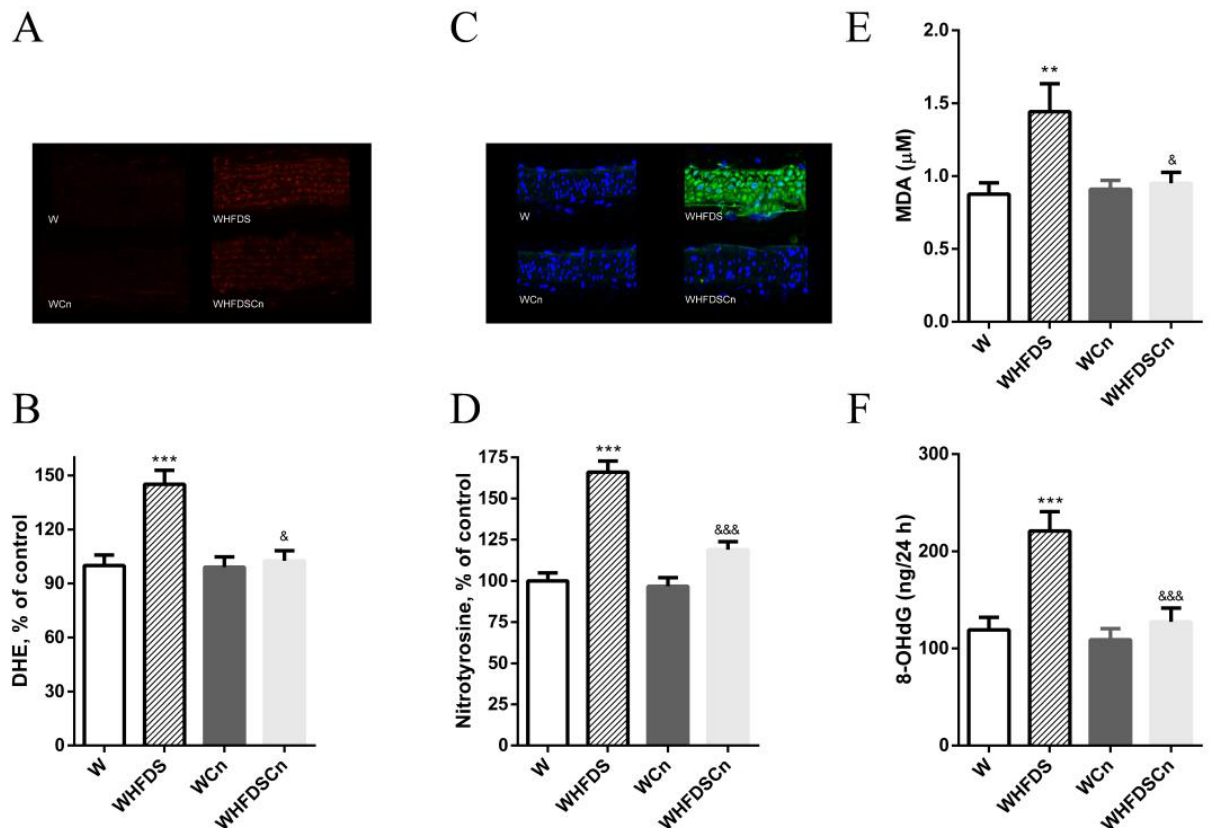
Figure 4. Effects of cinnamaldehyde (Cn) treatment on systemic and vascular oxidative stress in Wistar (W) rats fed with sucrose and high-fat diet (WHFDS) compared to normal W rats: ( A ) aorta artery sections representative of DHE-stained (O 2 •− production) in different groups; the endothelium is facing up; at identical settings, WHFDS fluorescence was significantly increased, reflecting O 2 • − levels in all layers of WHFDS aortas compared to normal W vessel; DHE fluorescence decreased in the WHFDS rats treated with Cn (WHFDSCn); ( B ) provides quantification of the red fluorescence; ( C ) mesenteric sections representative of nitrotyrosine staining in normal W, WHFDS